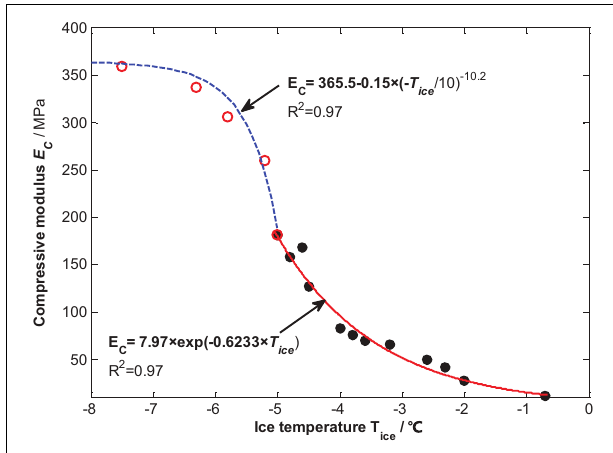
FIGURE 10 | Ice compressive modulus for various ice temperatures.